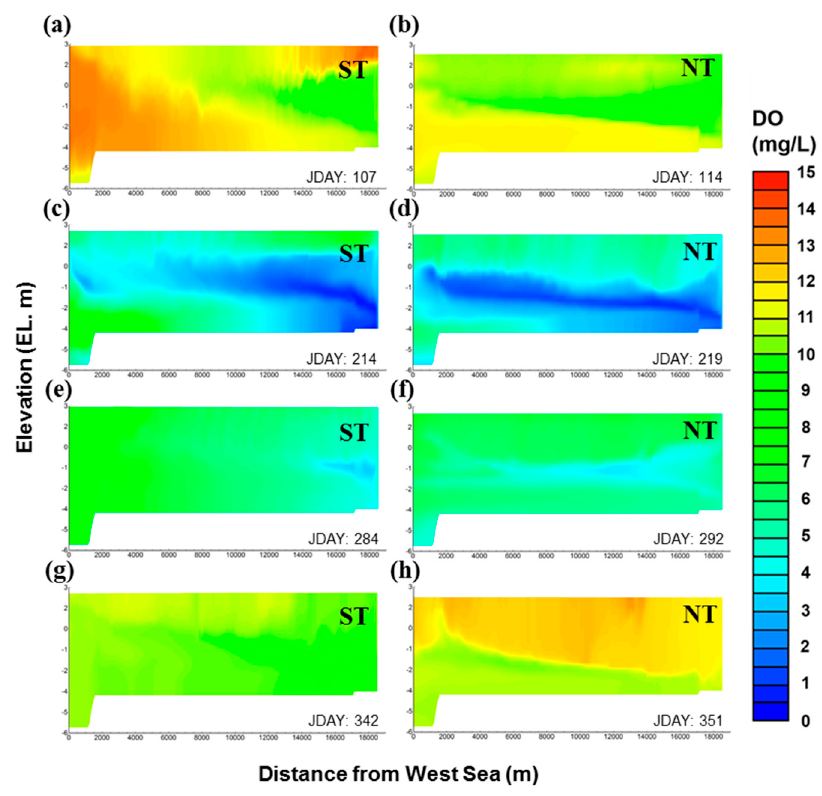
Figure 10. Spatial distributions of DO in each season in GAW; ( a , c , e , g ) ST and ( b , d , f , h ) NT; ST: spring tide, NT: neap tide.